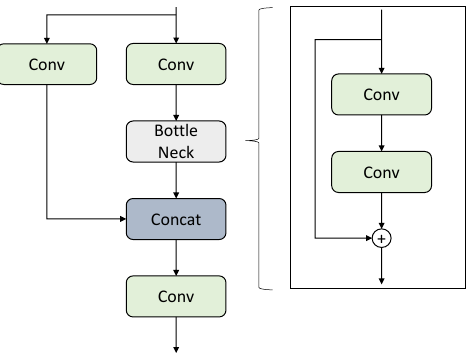
Figure 4. The architecture of the suggested model.